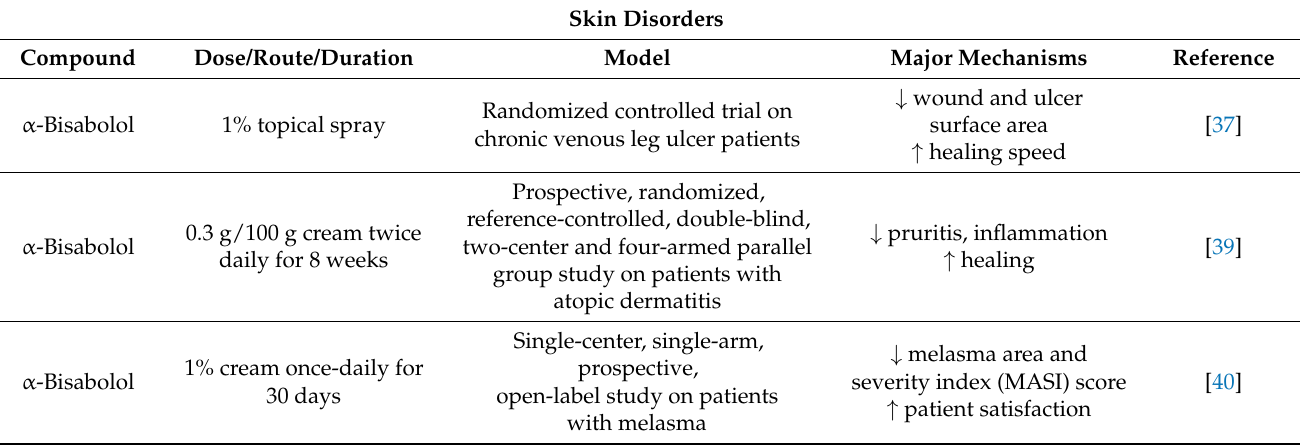
Table 3. Therapeutic effects and demonstrated mechanisms of α -Bisabolol in skin disorders.